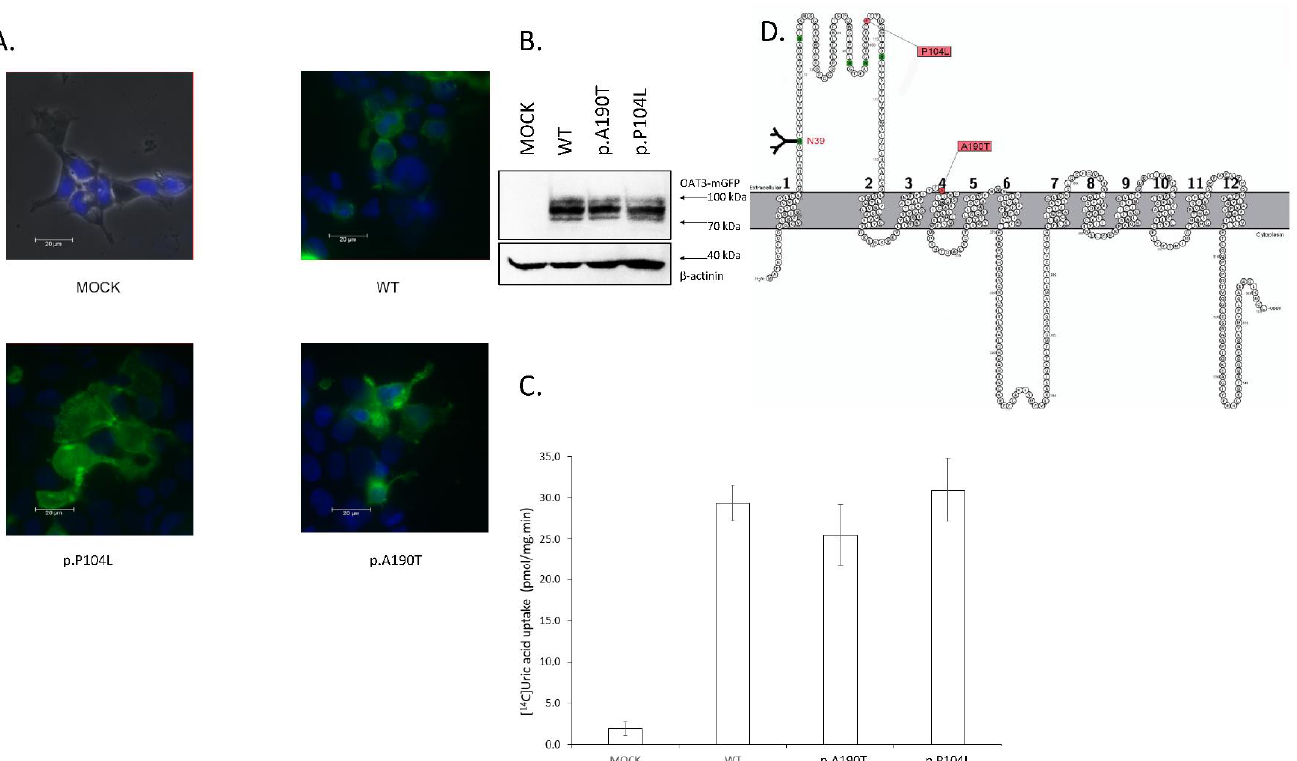
Figure 1. ( A ) Expression of SLC22A6 (OAT1) and it ´ s allelic variants in HEK293T cells line. Wild type protein was tagged with C-terminal GFP tag and cells was transiently transfected by polyethyleneimine lipofection. Samples was fixed by 4% paraformaldehyde and picture was take by Leica DM6 microscope in 400 × magnification. Plasmatic membrane localization was observed in all variants. Cell nucleus was stain by DAPI (blue). ( B ) Immunoblotting of HEK293T transfected by OAT3 WT and its allelic variant. Fusion protein OAT3-mGFP had majority band with molecular weight 90 kDa. CapZ ( β -actinin) protein is used as loading control and it had one major band with 42 kDa molecular weight. ( C ) Transport of 14 C radiolabeled uric acid by HEK293 cells transfected by OAT1 WT and its variant. The data are shown as pmol uric acid transported into the cytoplasm per one minute and total protein. Data are expressed with ± SD, n = 2. Statistical analyses for significant differnces was calculate by Students t -test ( D ) Topological model of human OAT1 protein (encoded by gene SLC22A6 ). Allelic variants p.P104L and p.A190T (single amino acid exchange) are colored by pink color. Asparagine 39 is N-linked glycosilated, other putative glycosylation motifs are colored by green. Edited on the base